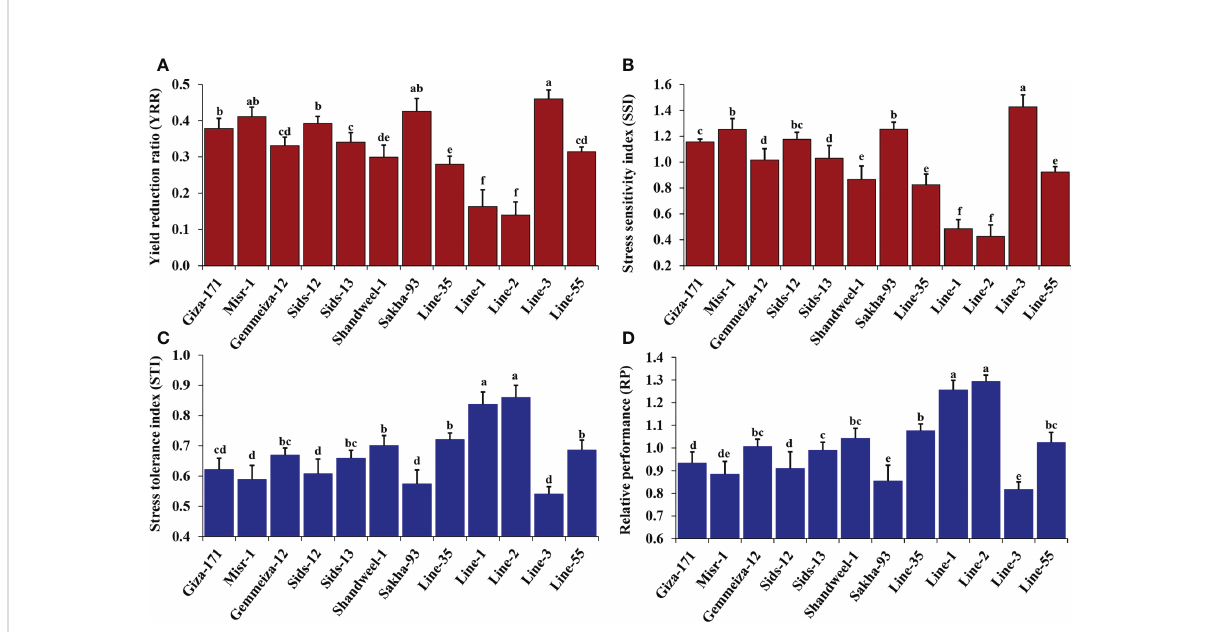
FIGURE 1 Heat tolerance indices: yield reduction ratio, YRR (A) , stress sensitivity index, SSI (B) , stress tolerance index, STI (C) , and relative performance, RP (D) for the evaluated twelve bread wheat genotypes averaged over two locations and two growing seasons. The bars on the columns represent SE, and different letters are signi fi cantly different by the least signi fi cant difference at p ≤